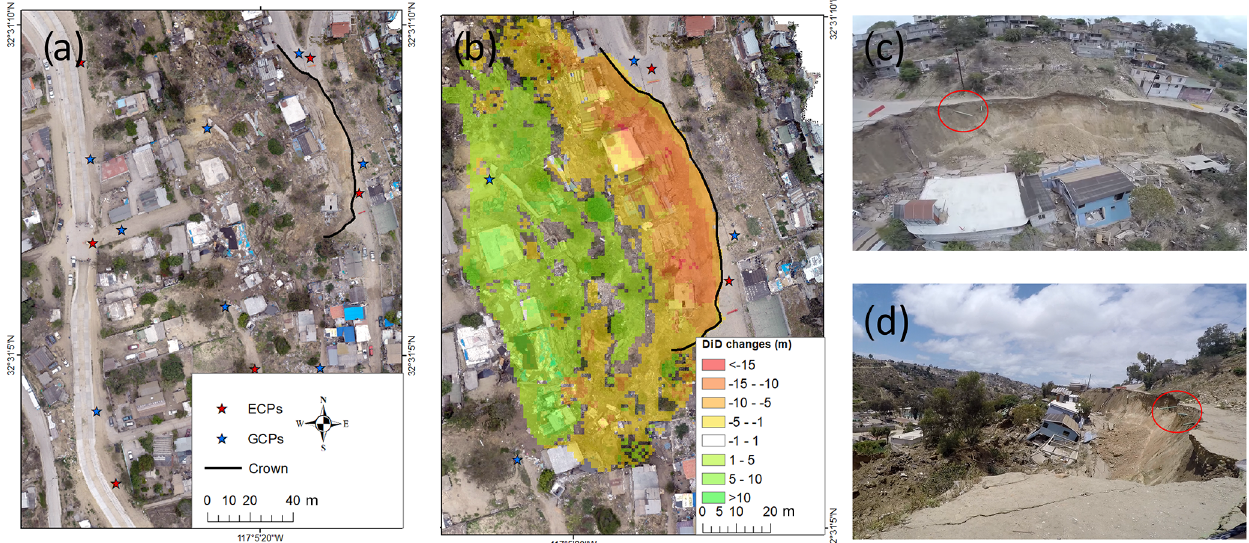
Figure 3. Landslide event on 15 May 2015 triggered by water main leak and rainfall: (a) orthophoto acquired after the WRIF showing the upper limit of the main scarp (crown) with the black line, (b) the DiD changes from the multi-temporal analysis, and (c) oblique aerial and (d) ground-based photographs of the landslide showing broken water mains inside the red circle aligned with the main